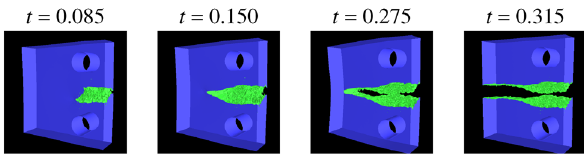
Fig. 10 Slanting initial crack growth under a given boundary dis- placement g = ± t ( 0,2,0 ) . To visualize the crack growth clearly, the pictures are drawn from the opposite